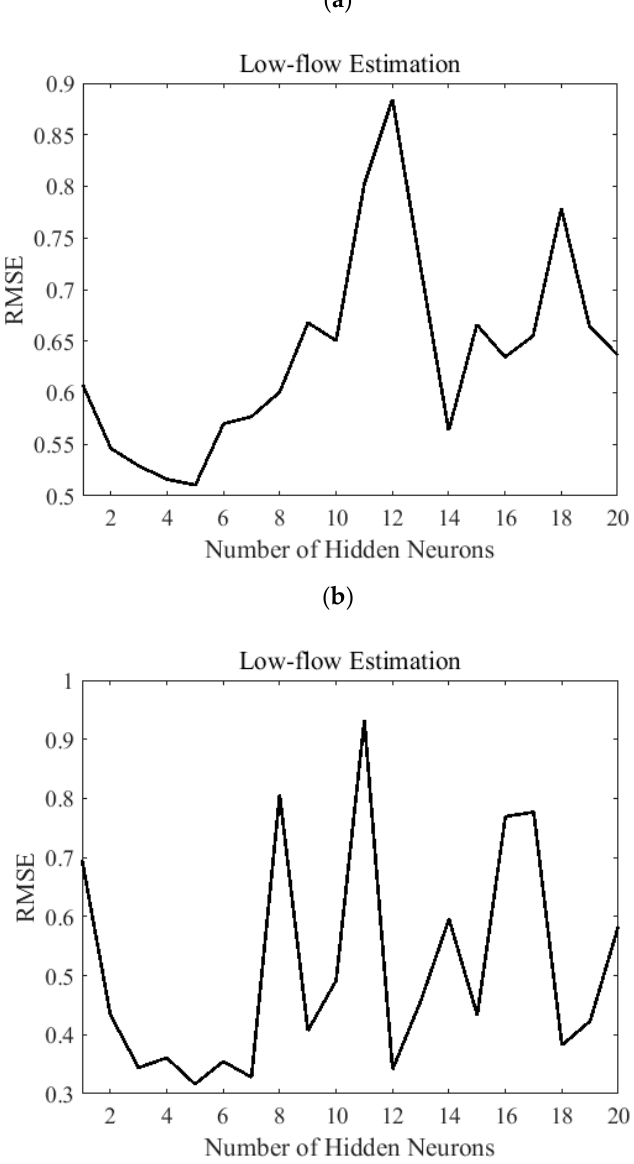
Figure 6. RMSE of the low-flow estimation using the ensemble artificial neural networks with the number of hidden neurons ranging from 1 to 20 for the ( a ) two-year quantile and (b) five-year quantile derived from the Gamma distribution.